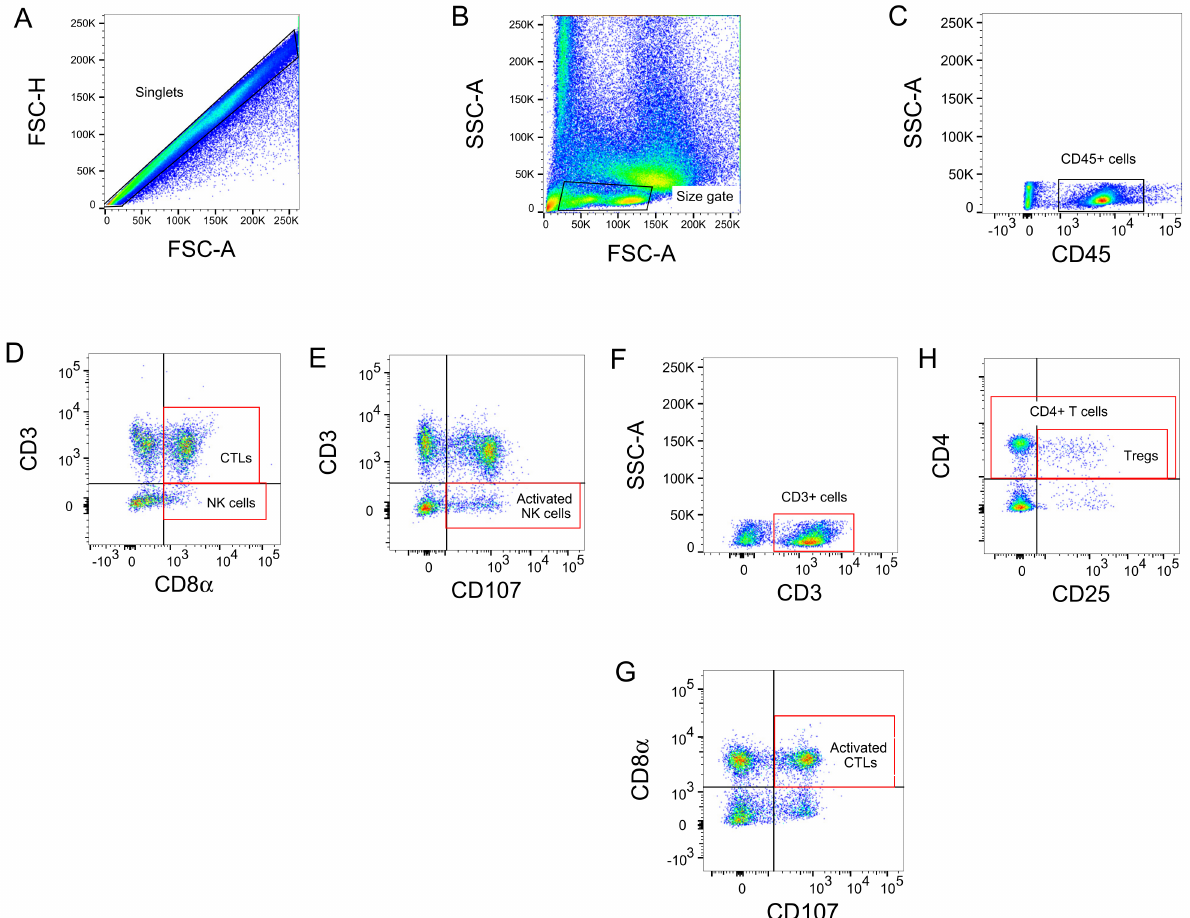
Figure 1. Contour plots of windows and gating strategy used for the identification of immune cells using flow cytometry: ( A ) singlets cells; ( B ) size gate for lymphocytes; ( C ) CD45 + cells; ( D ) CTLs (CD3 + CD8 α + ) and NK Cells (CD3 − CD8 α + ); ( E ) activated NK cells (CD3 − CD107 + ); ( F , G ) activated CTLs (CD3 + CD8 α + CD107 + ); ( H ) CD4 + T cells and Tregs cells (CD4 + CD25 +